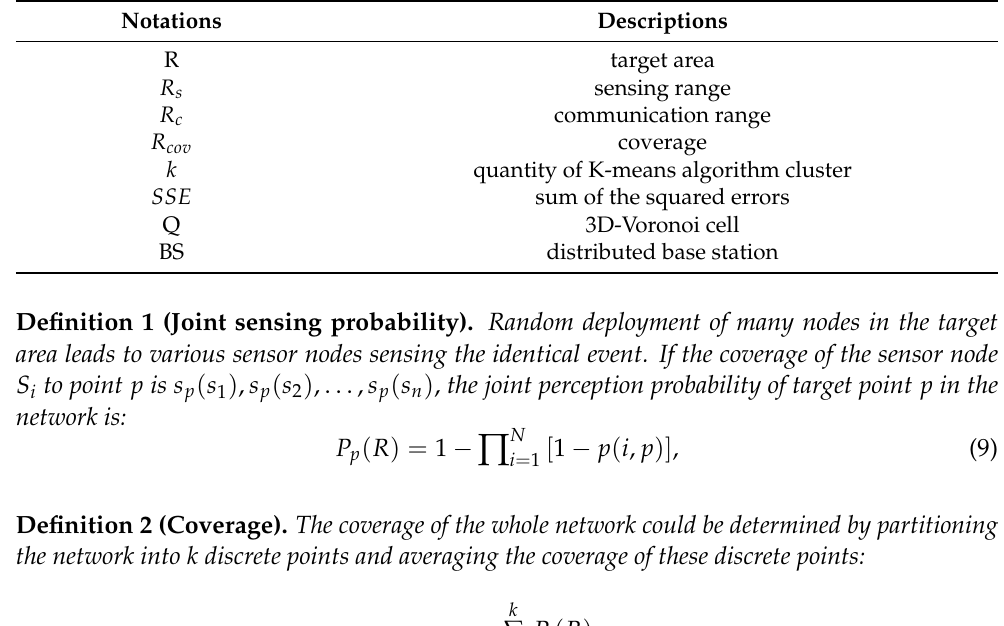
Table 1. Notations and